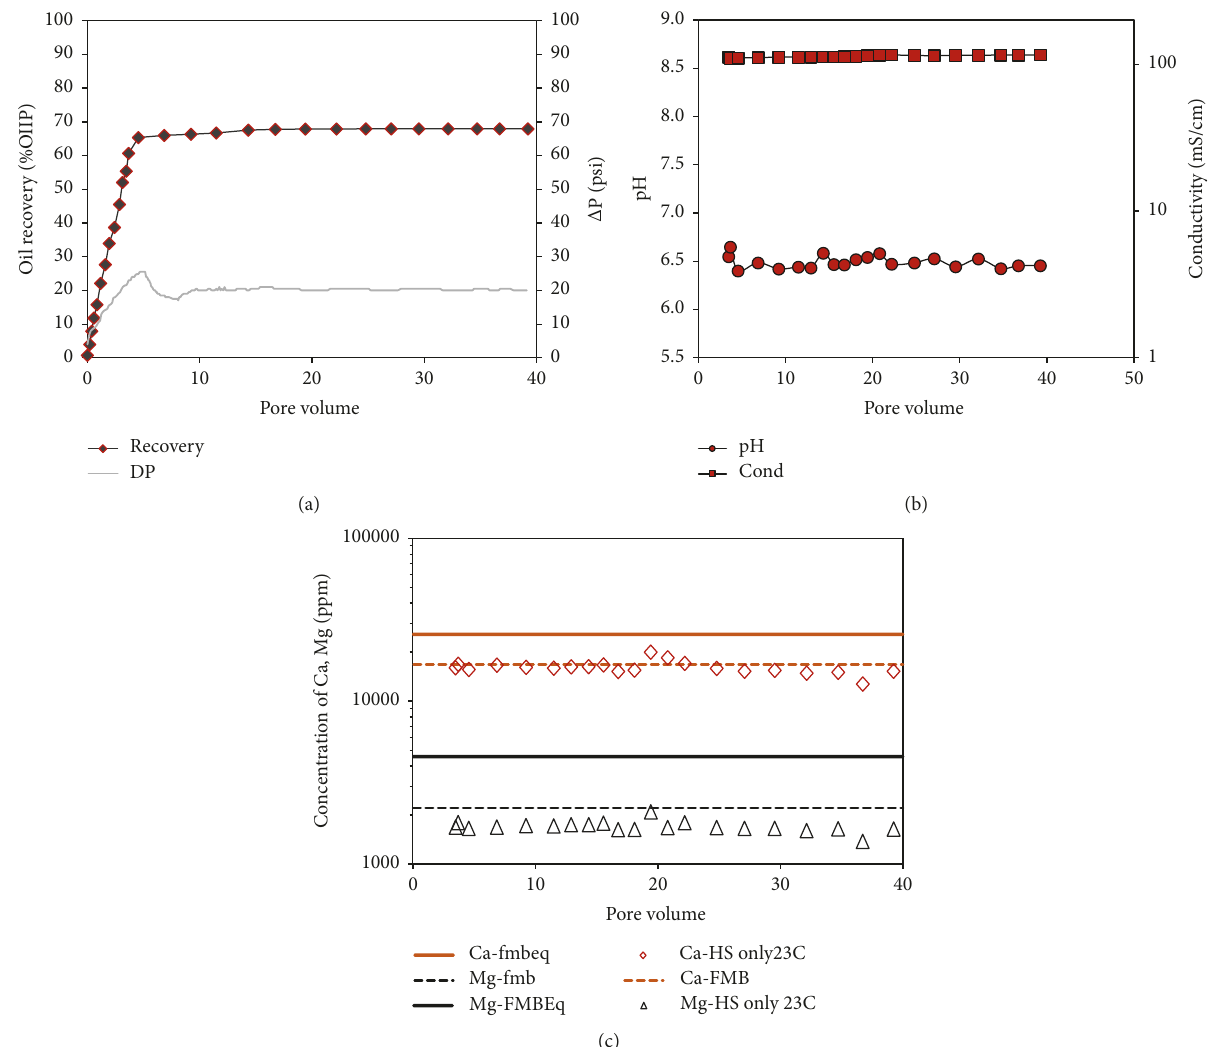
Figure 6: Secondary FMB flooding on core C30, (a) cumulative oil recovery and differential pressure; (b) pH (circles) and conductivity (squares) of effluents; (c) Ca 2+ (rhombi) and Mg 2+ (triangles) ions of effluents. The straight lines indicate concentration of Ca 2+ (coloured) and Mg 2+ (black) in connate water saturation (—) and injected brine